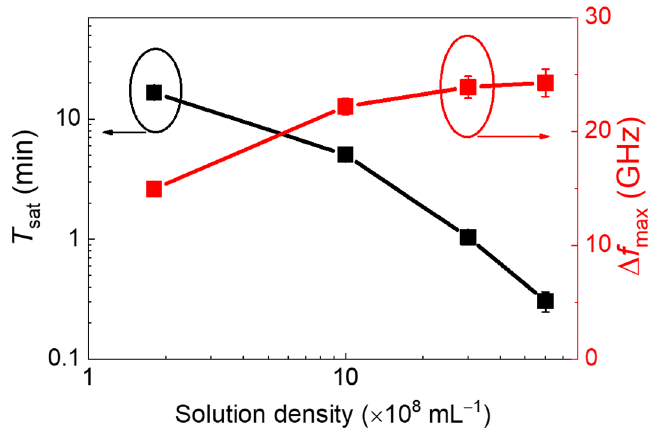
Figure 4. Saturation time of the resonant frequency shift (black square dots), and saturated resonant frequency shift (red square dots) as a function of the PS solution density. Error bars indicate the standard deviation extracted from the fitting process.